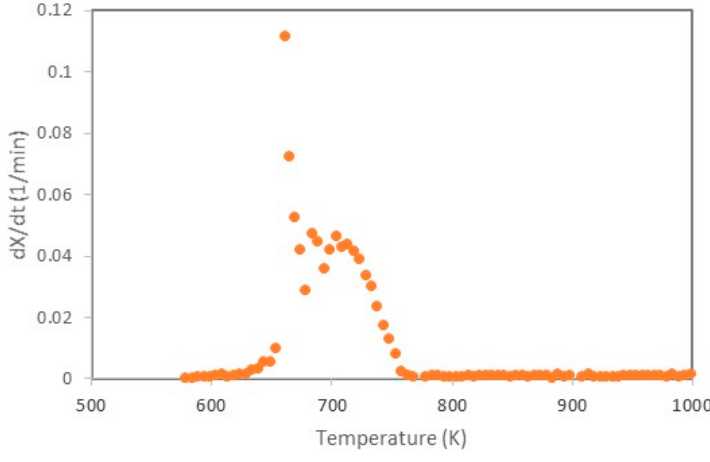
Figure 9. DTG curves on the soot sample in air at 5 K/min.